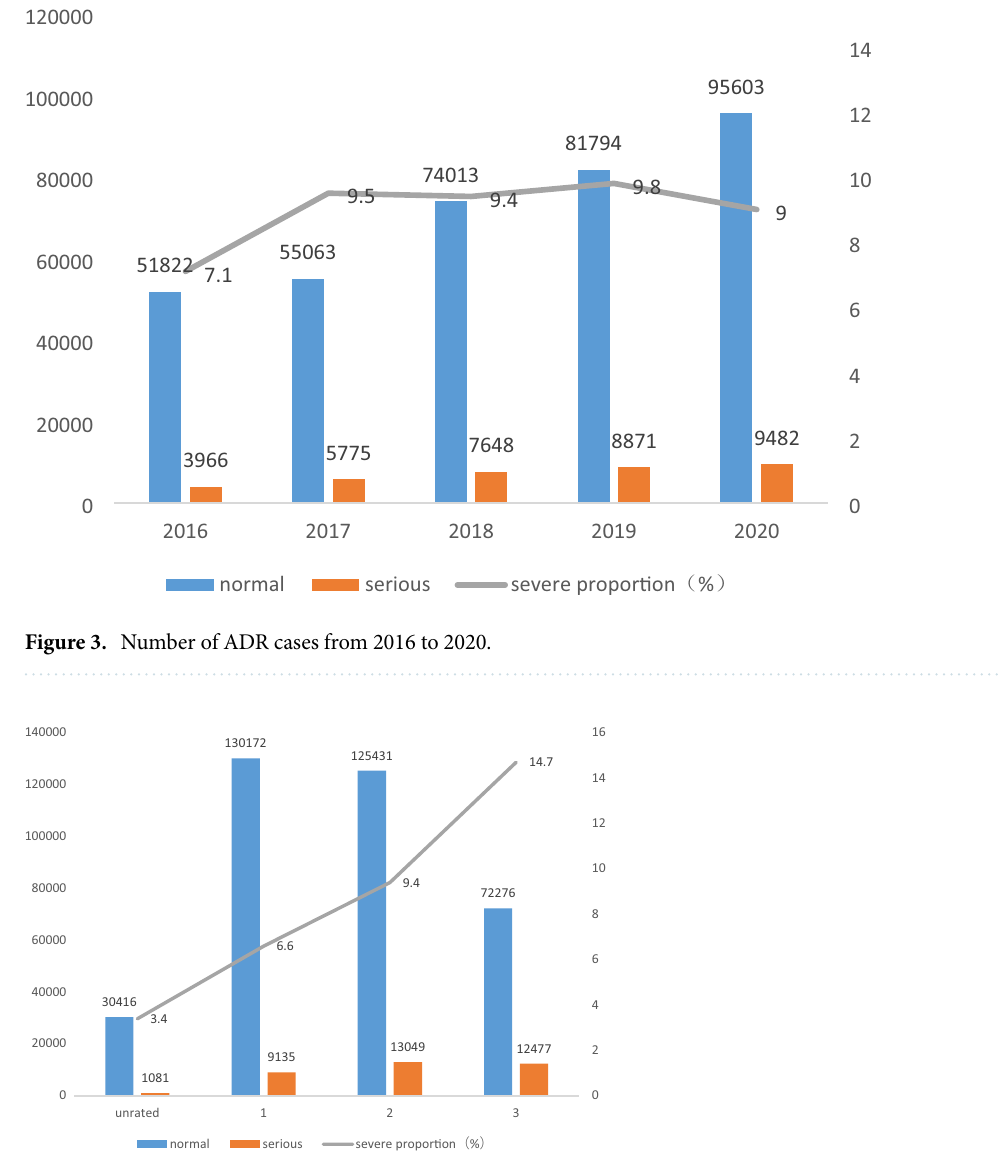
Figure 4. The proportion of SADRs in different levels of medical